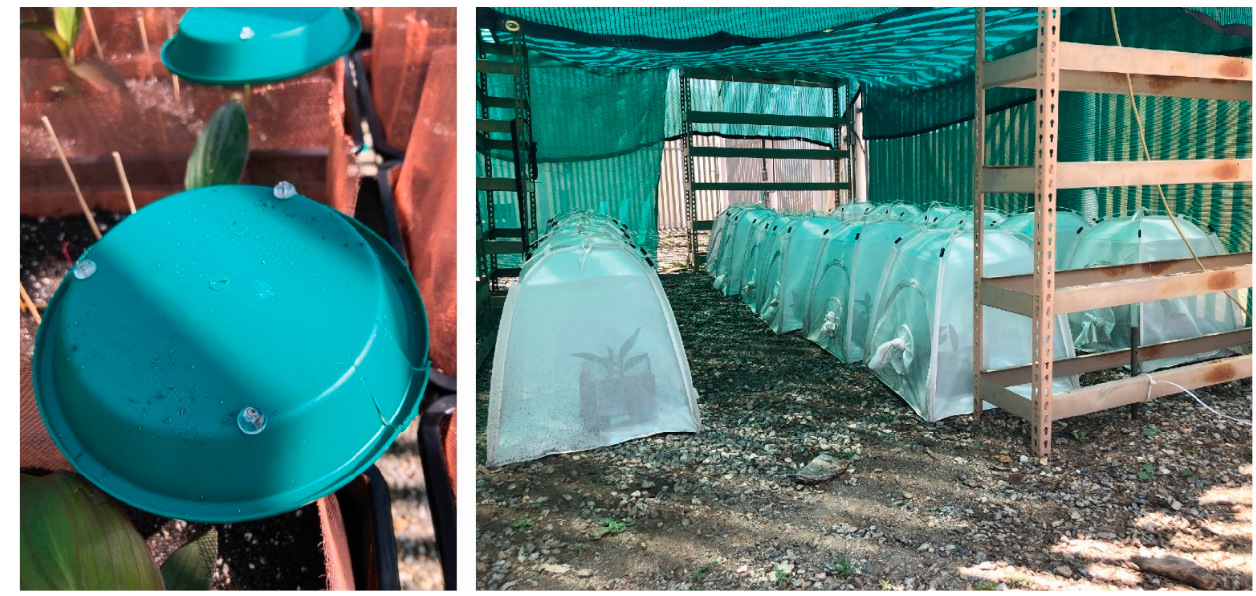
Figure 1. Potholders on pin stilts ( left ) which functioned as slug shelters between Canna ‘Cannova ® Bronze Scarlet Canna Lily’. The arenas were used to determine the mortality of Deroceras reticulatum exposed to three Phasmarhabditis species. The arrangement of bug dorms with arenas inside the lath house ( right ).